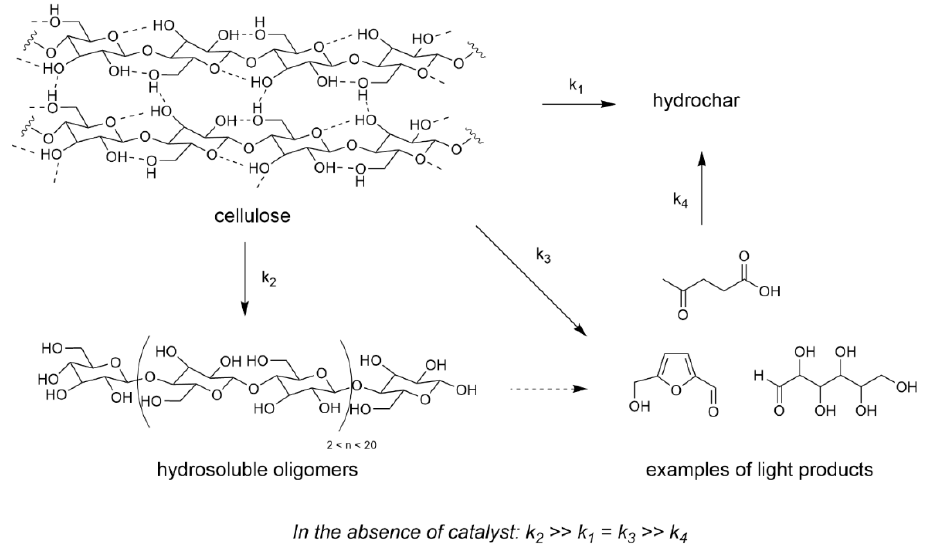
Scheme 2. Reaction pathway for non-catalyzed cellulose liquefaction (water 60 mL, Avicel cellulose